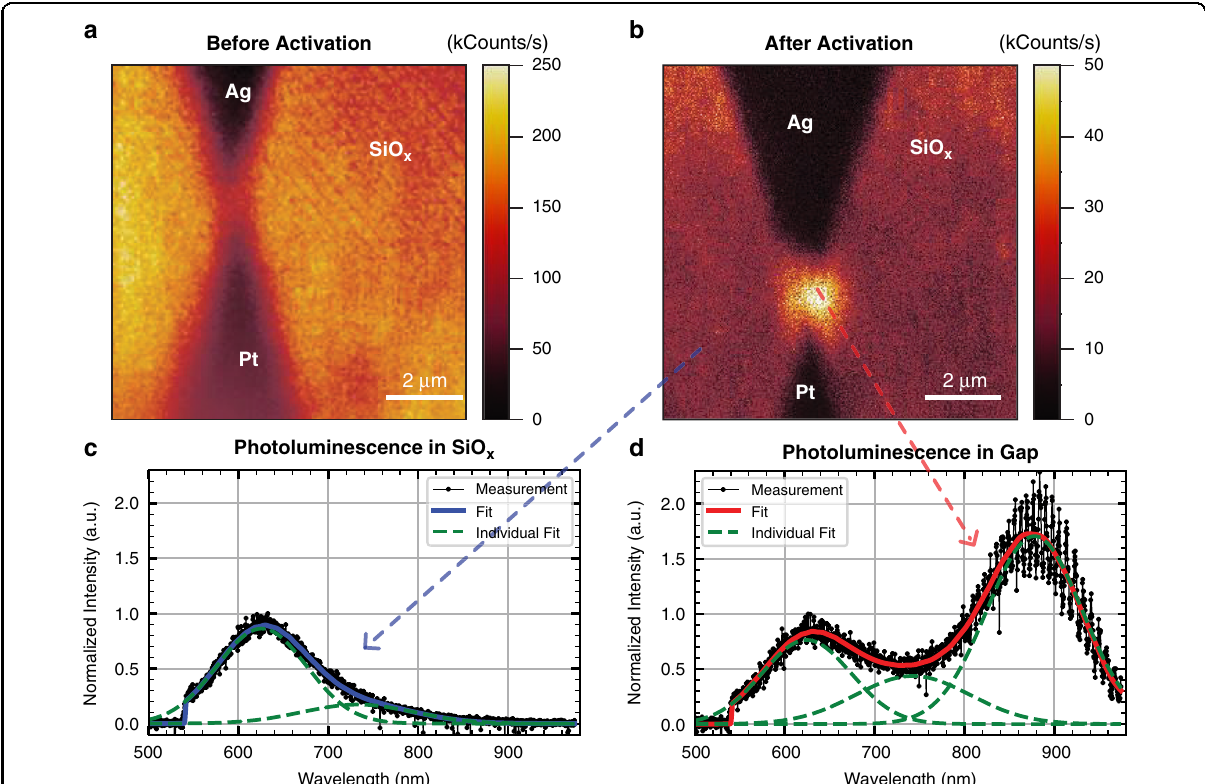
Fig. 5 PL measurement indicating the creation of luminescent defects created by resistive switching. a Confocal PL scan of the pristine device. The laser power is 1 µW with an integration time of 1 ms per pixel. b Confocal PL scan of the device after activation and switching. The laser power is 300 nW with an integration time of 0.5 ms per pixel, which yields an approximately 6 times weaker PL for the SiO x (25 kHz in b and 160 kHz in a ). c PL spectrum taken at a SiO x spot outside of the gap. Gaussian fi ts are used to decompose the spectrum. Two spectral components (green dashed lines) are identi fi ed that contribute to the overall emission. d PL spectrum taken in the gap. A new dominant emission around 875 nm is found. This is best seen from the fi t with Gaussian functions. Note that the intrinsic peak at 625 nm in both c and d are normalized to the same